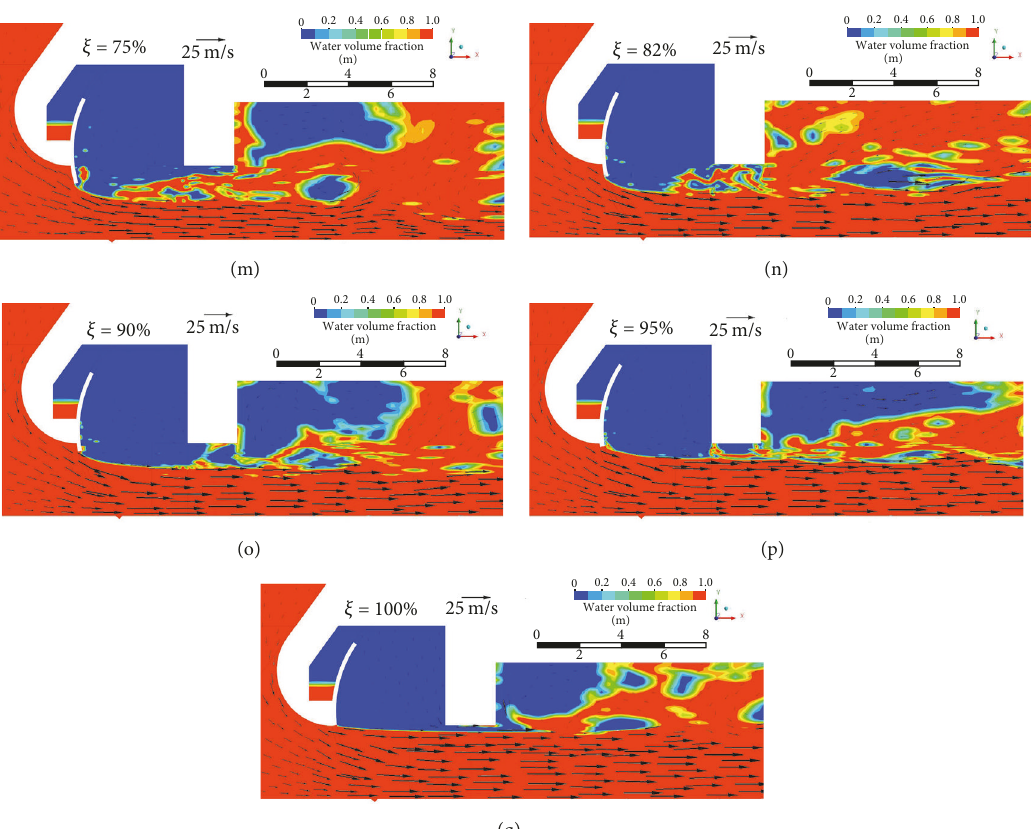
Figure 10: Sequential snapshots of the submerged outflow from the radial gate from 𝜉 = 7 to 100%. The instantaneous patterns are colored by VOF and the velocity field is illustrated by velocity vectors.